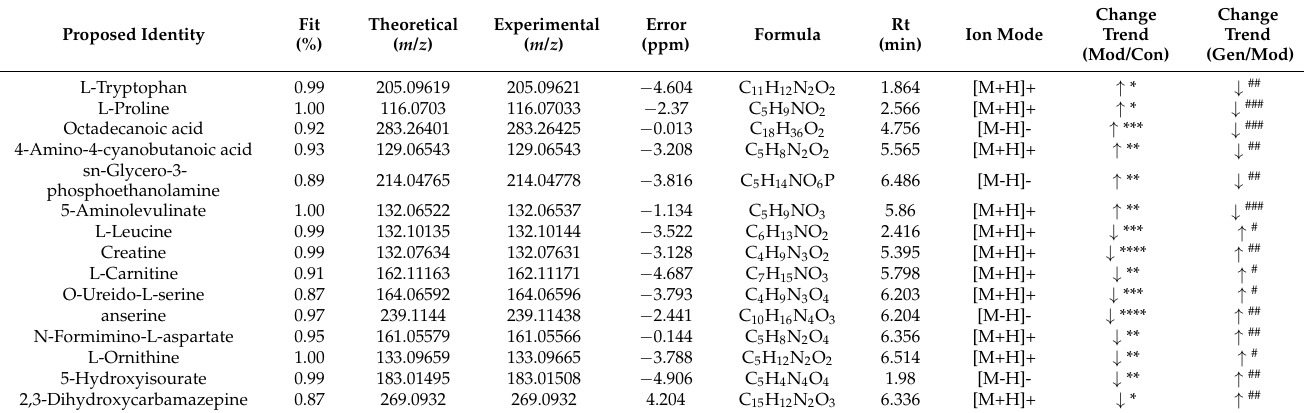
Table 2. Identified potential biomarkers regulated by